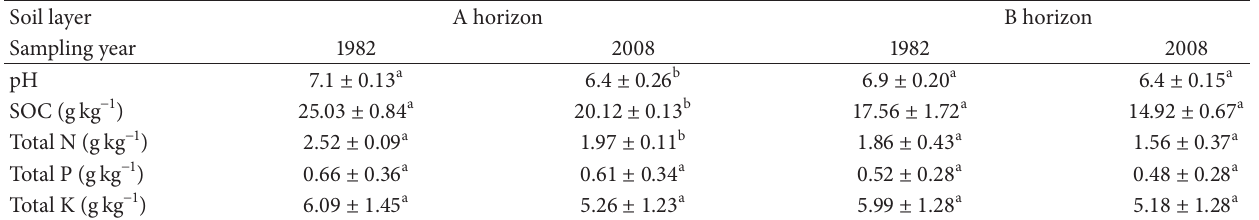
Table 2: Changes in soil properties under C. cathayensis forest stands after 26 years intensive management.